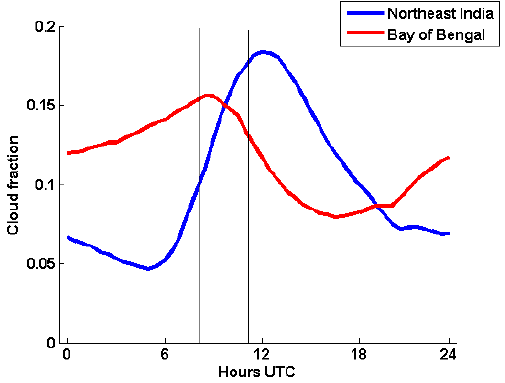
Fig. 9: Spatial distribution (from left to right panel) of uncorrected (original) AVHRR convective cloud fraction, corrected AVHRR cloud fraction after removing the drift signal, corresponding MODIS cloud fraction and the difference of uncorrected AVHRR and corrected AVHRR convective cloud fractions for the JJAS months of 2006.